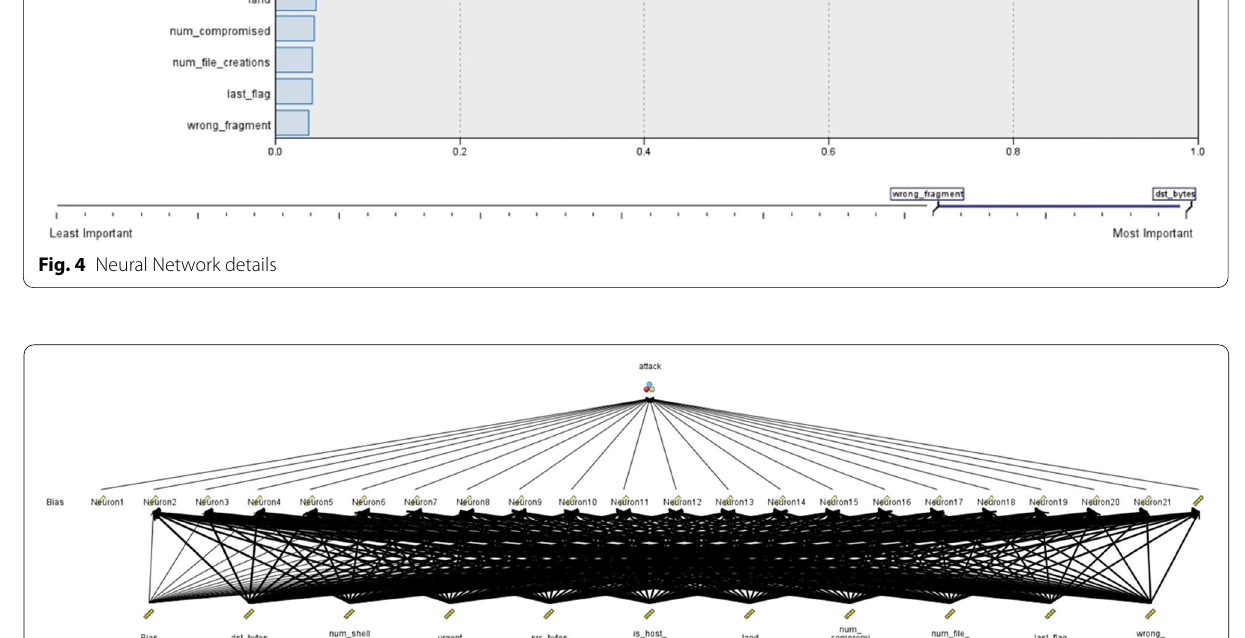
Fig. 5 Neural Network